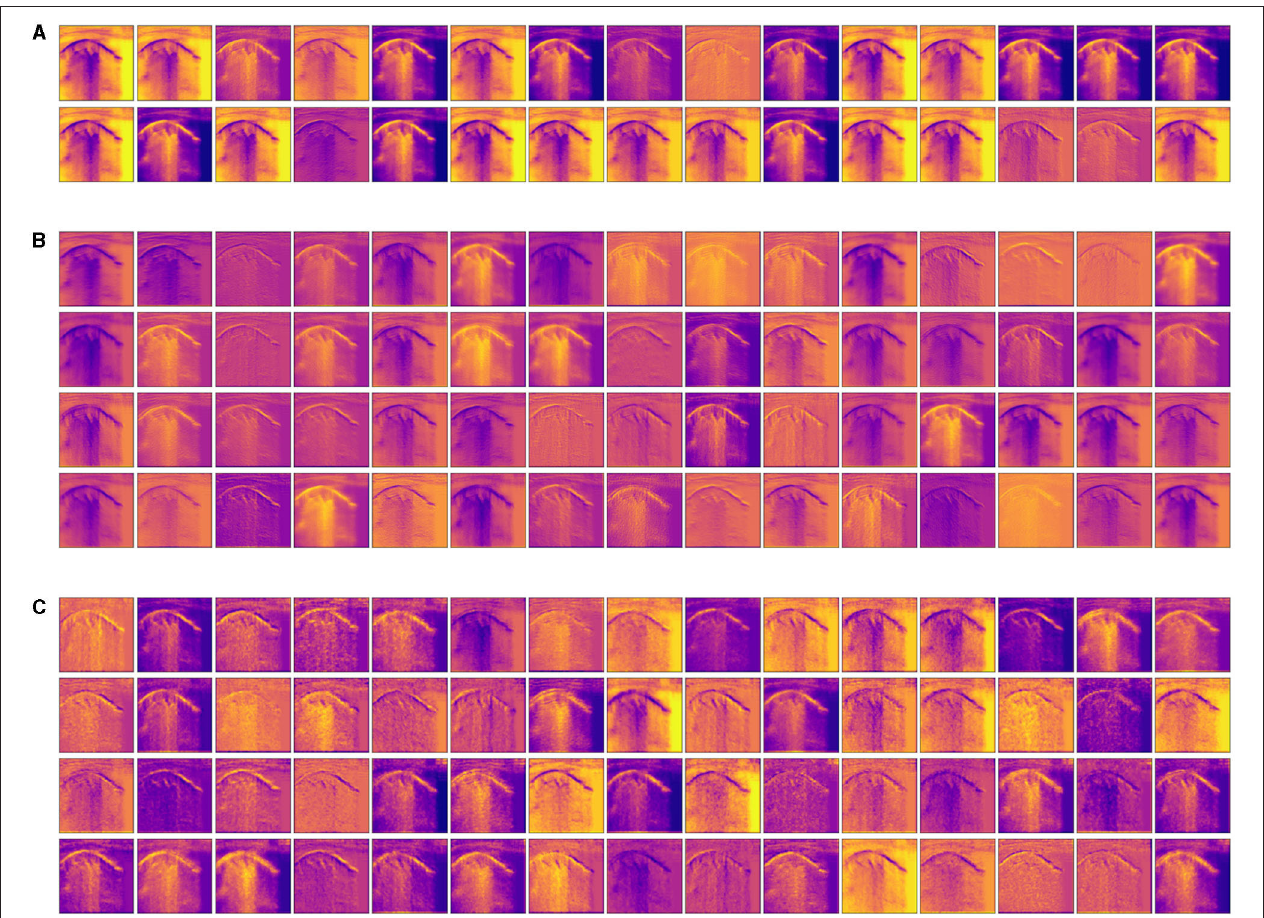
FIGURE 4 | Visualization of the activation maps from (A) the first, (B) the third, and (C) the fourth convolutional layer of the best performance model (Inception-v3) on the three-class classification problem, when fed with an image of a lung with bronchiolitis. Filters act as collections of edge detectors, detect background, contours, and texture-like patterns. When going deeper in the layers, the filters enhance differently vertical artifacts and small consolidation-like patterns that are typical of bronchiolitis.